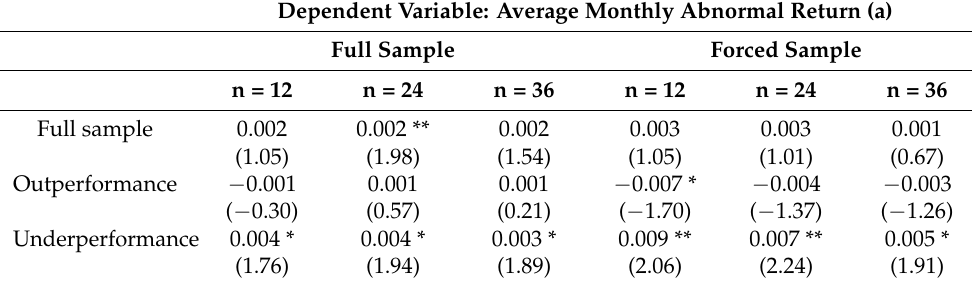
Table 10. Calendar-time Fama and French three-factor